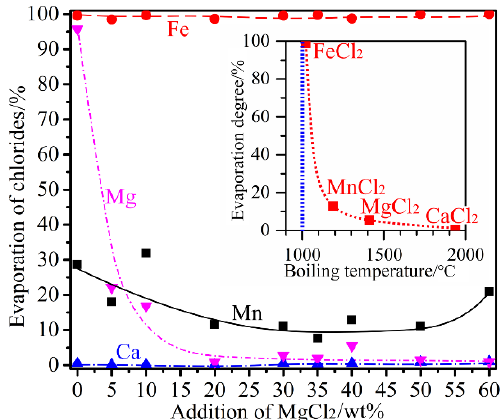
Figure 11. Evaporation degree of metal chlorides vs. the addition of various amounts of MgCl 2 and 20 wt% CaCl 2 before carbothermic reduction. Inset illustrates the correlation between the evaporation degree of divalent metal chlorides at 40 wt% MgCl 2 addition and their respective boiling temperatures (boiling temperatures cited from reference [33]).